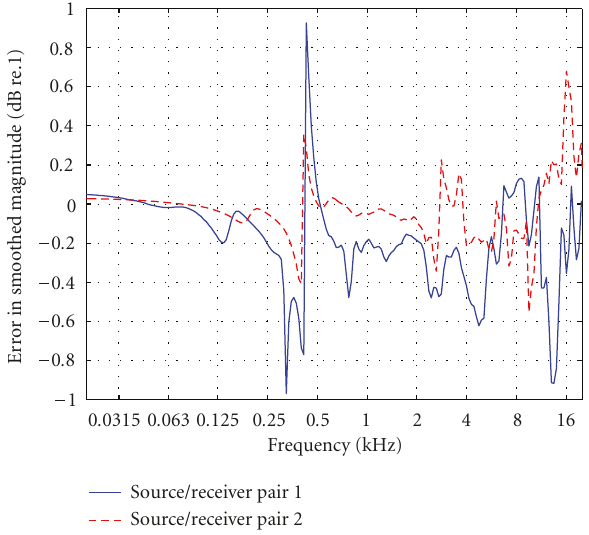
Figure 9: Error in the smoothed spectrum for di ff raction approxi- mations utilizing the geometry in Figure 4. The solid line is the er- ror for the example shown in Figures 7 and 8 using S 1 and R 1 and the parameters in Line 1 of Table 1. The dashed line is the error for an approximation using S 2 and R 2 and the parameters in Line 7